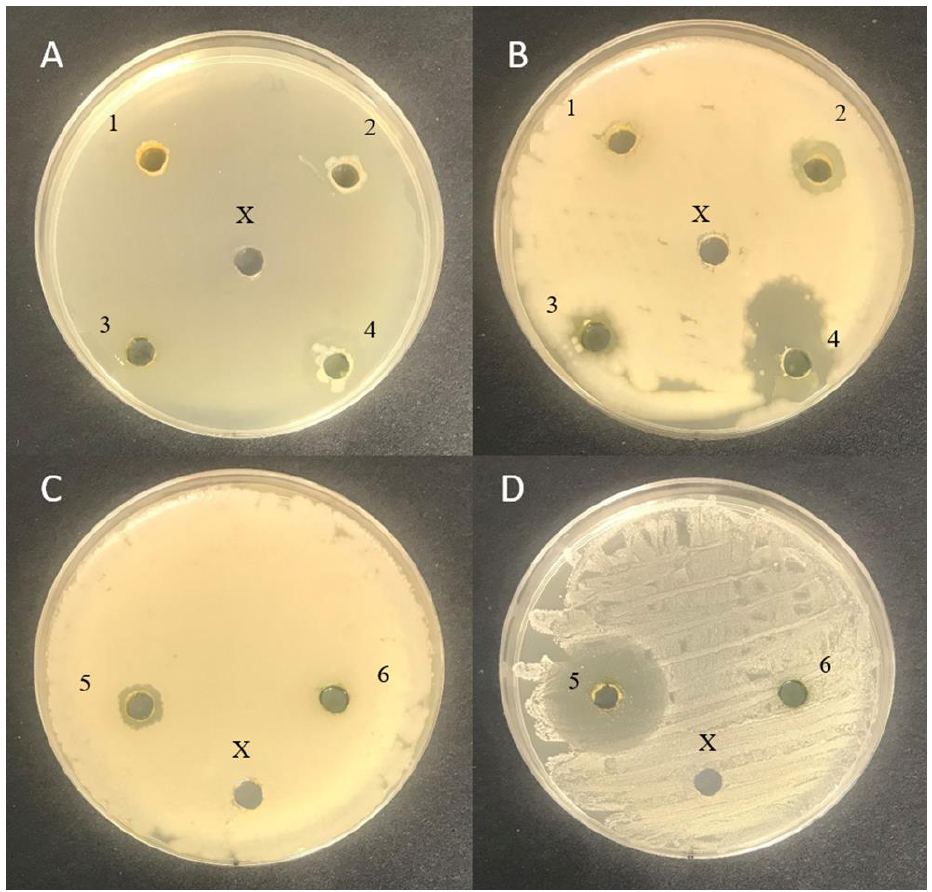
Figure 5. Antimicrobial activity of the algal extract samples assessed by using the agar well diffusion method ( A ) Streptococcus mutans ; ( B ) Bacillus subtilis ; ( C ) Bacillus subtilis ; ( D ) Staphylococcus haemolyticus ; 1—Spirulina ( Arthrospira platensis ) from University of Texas; 2— Chlorella vulgaris ; 3— Cladophora rupestris ; 4— Furcellaria lumbricalis ; 5— Ulva intestinalis ; 6—Spirulina (Ltd. „Spila“); X—control (physiological solution).